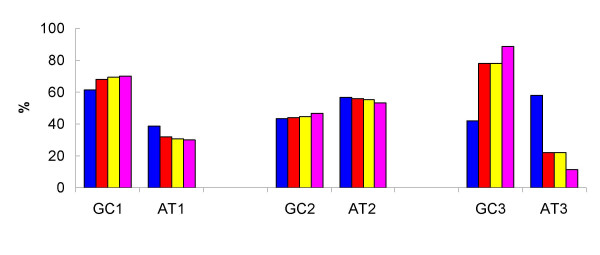
Codon usage in halophilic archaea. Indicated is the percentage of G plus C or A plus T at the different codon positions showing the large difference between H. walsbyi and the other haloarchaea especially at the third codon position. Bars are H. walsbyi (blue), H. marismortui (red), N. pharaonis (yellow) and H. salinarum (purple).